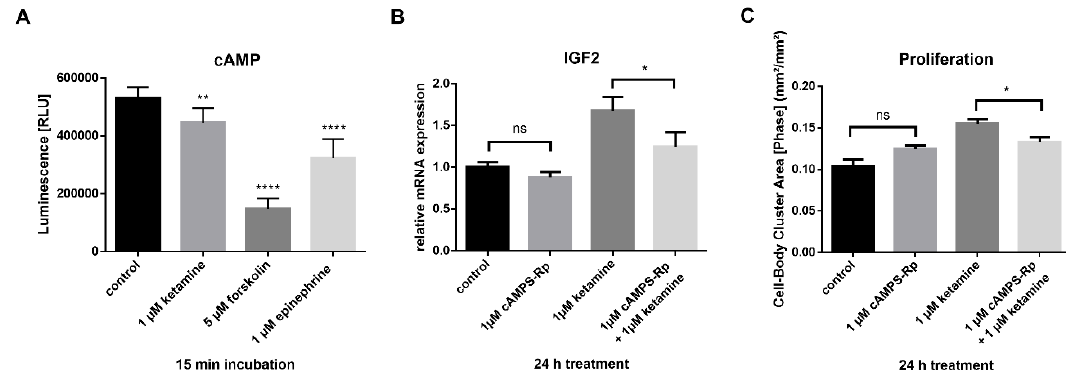
Figure 7. cAMP-IGF2 signaling is involved in ketamine’s proliferative effect. ( A ) Ketamine increased cAMP levels within 15 min. Intracellular cAMP levels were determined using the cAMP-Glo™ assay. Luminescence is inversely proportional to cAMP levels. IMR90 NPCs were treated for 15 min with the indicated compounds. Forskolin (adenylyl cyclase activator) and epinephrine (an agonist of adrenergic receptors) were used as positive controls. ( B ) Induction of IGF2 mRNA expression by ketamine was reduced after PKA inhibition. Cells were pretreated with 1 µM cAMPS-Rp for 15 min before ketamine or dimethyl sulfoxide (DMSO) control was added. ( C ) Inhibition of intracellular cAMP signaling reduced the effect of ketamine on proliferation. Effect on proliferation is shown at the selected time point of 24 h compared to DMSO control (n = 3). The data represent the means of three independent experiments. Error bars were calculated using ±SEM. p-values were calculated against DMSO control.